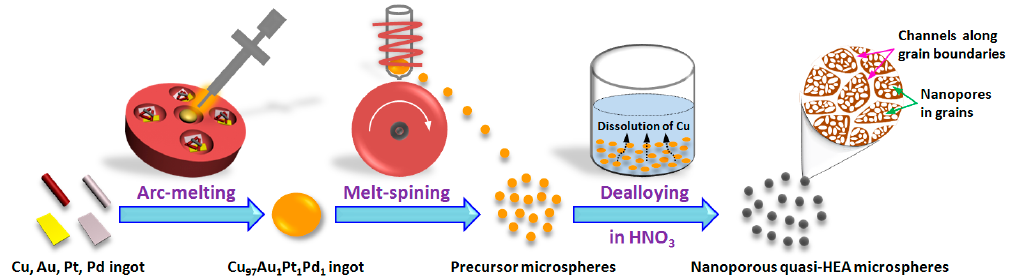
Figure 1. The synthesis process of nanoporous quasi-HEA microspheres.